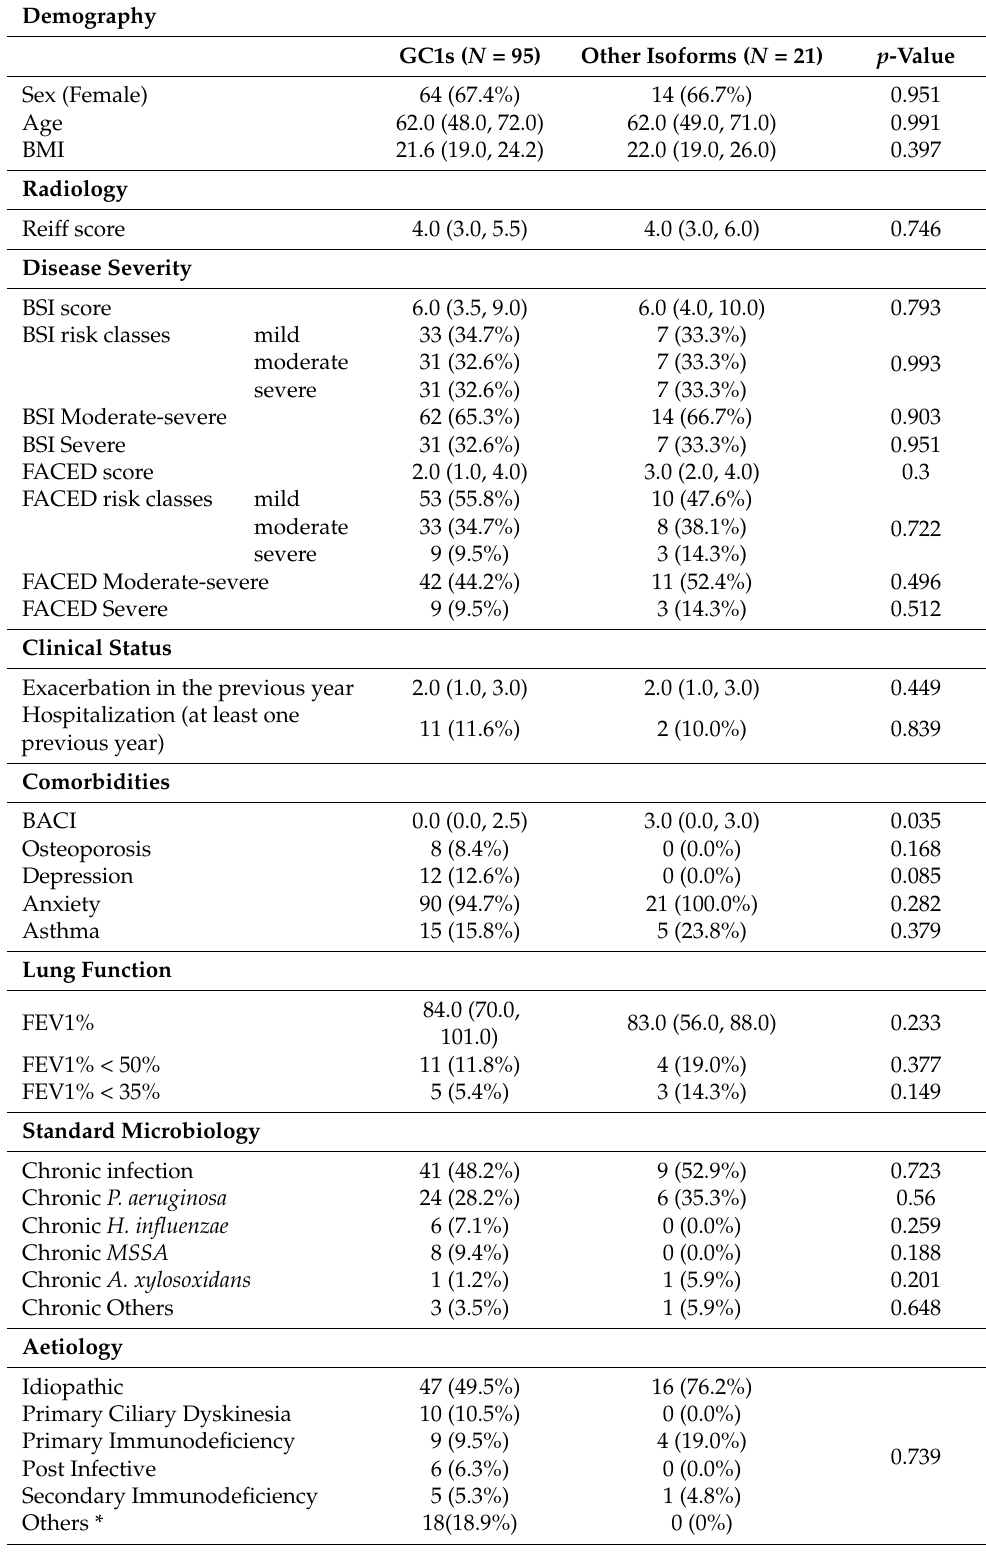
Table 4. Comparison of clinical characteristics of patients with GC1s isoform vs.